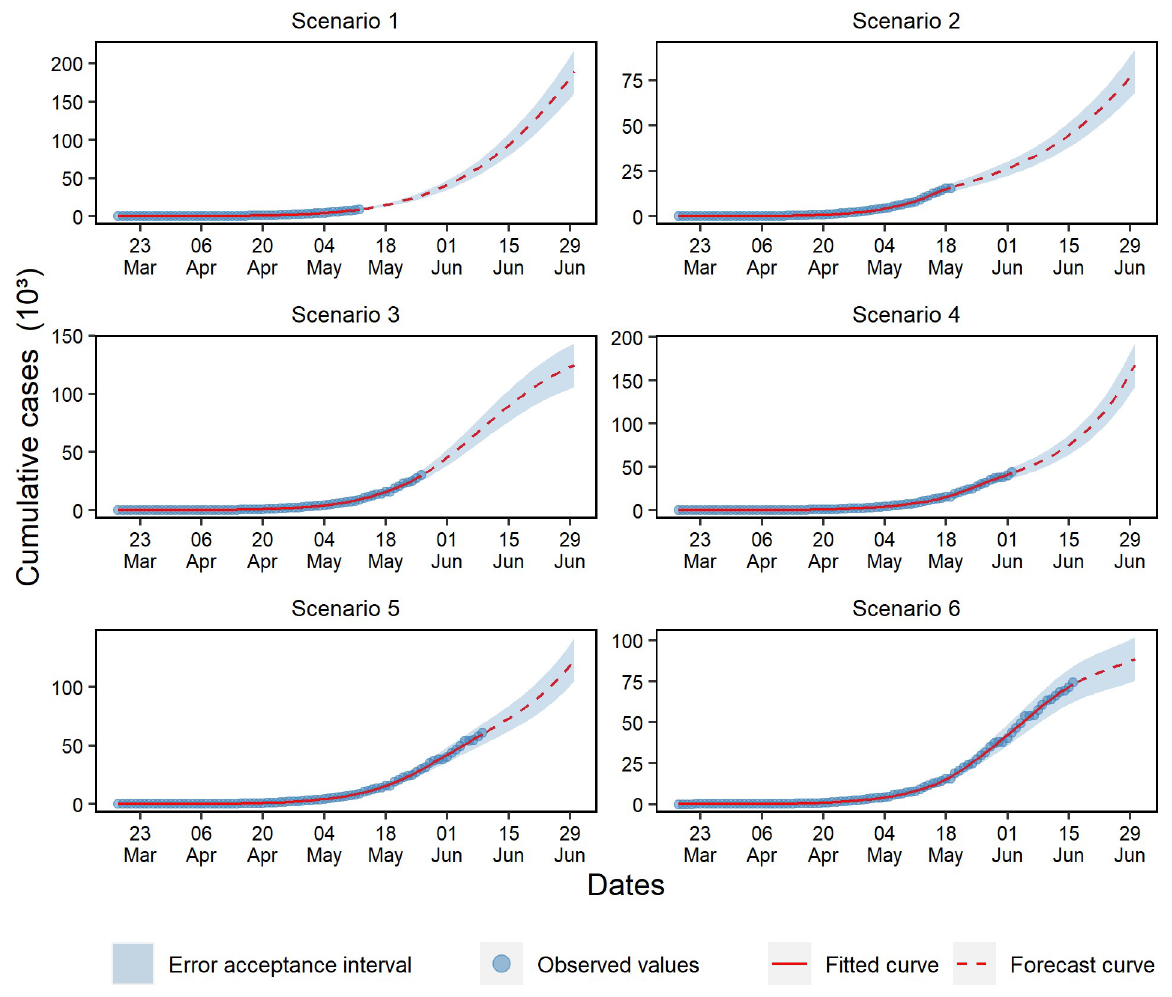
Fig 4. Forecasting of cumulative cases in the six analyzed